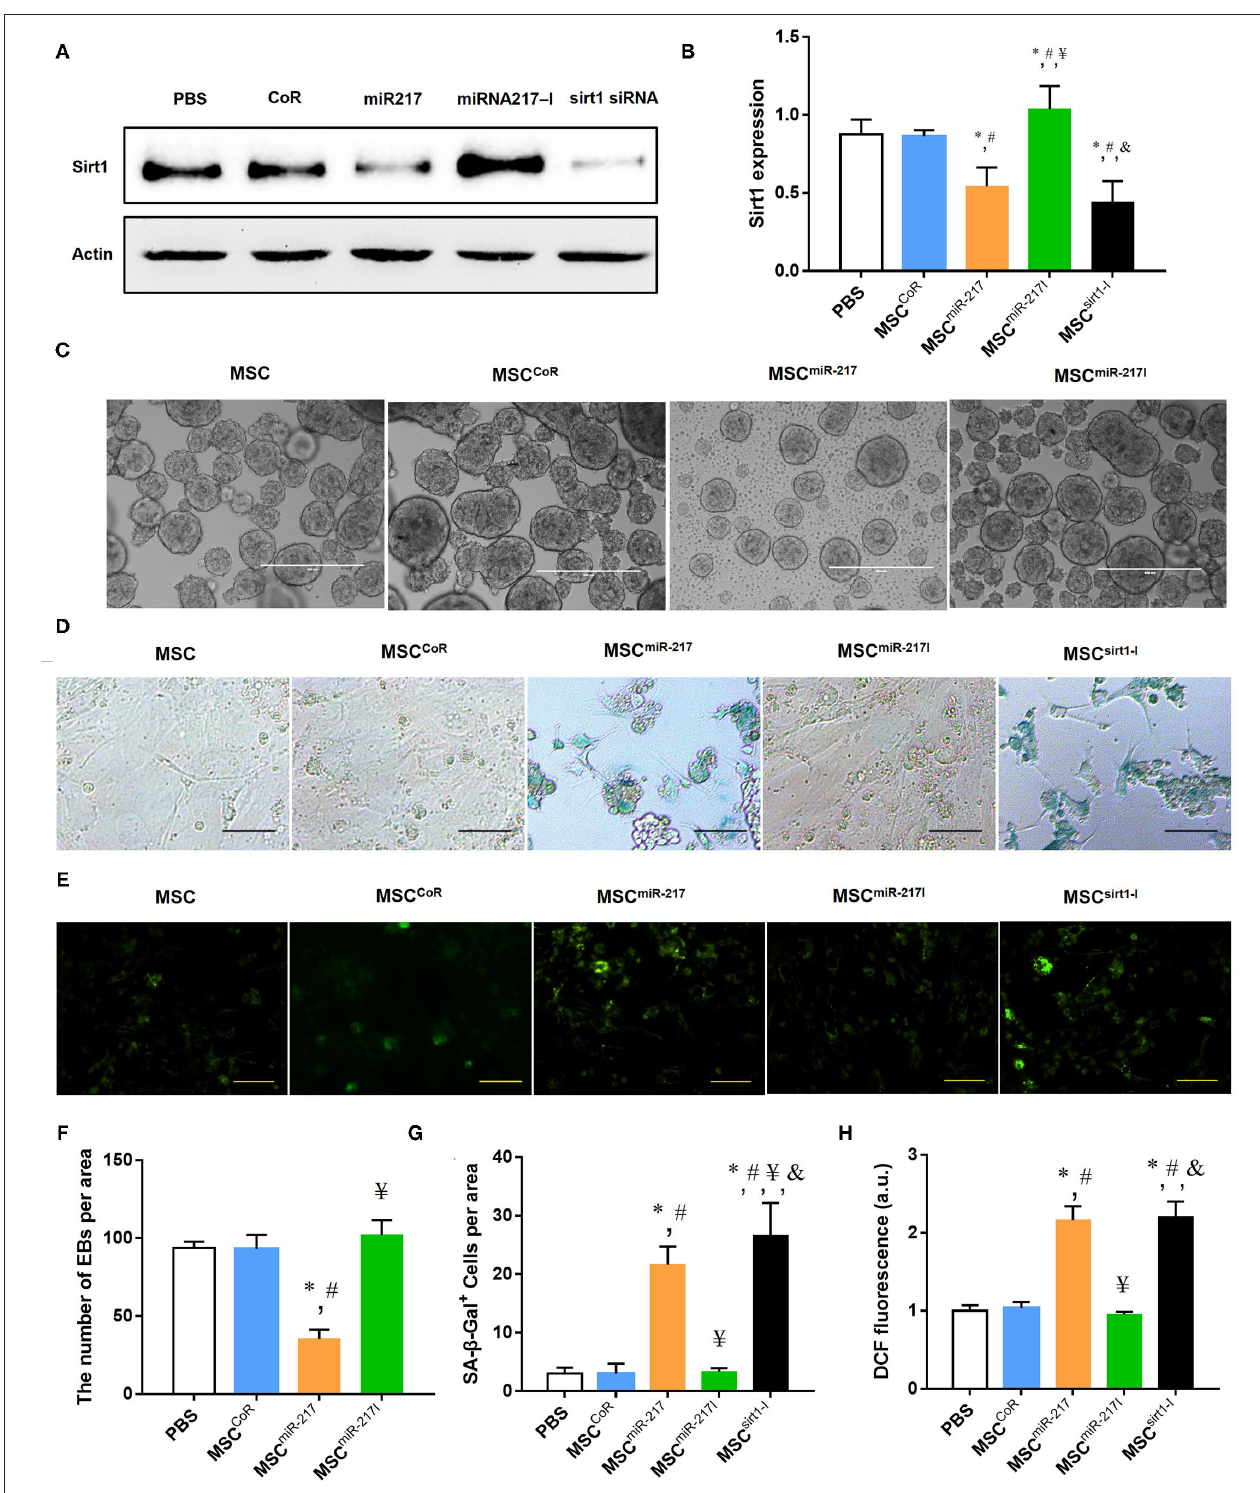
FIGURE 4 | MiR-217 overexpression in MSCs reduces Sirt-1 expression, induces malformation of EBs, increased senescence and ROS activity. (A) A comparative analysis of the Sirt-1 expression in intact MSCs and MSC CoR , MSC miR − 217 , MSC miR − 217I , MSC Sirt1 − I by Western blot. (B) Protein quantification by band densitometry in gels shown in panel (A) , * P < 0.05 vs. PBS, # P < 0.05 vs. MSC CoR , U P < 0.05 vs. MSC miR − 217 , & P < 0.05 vs. MSC miR − 217I , n = 3. (C) Representative images